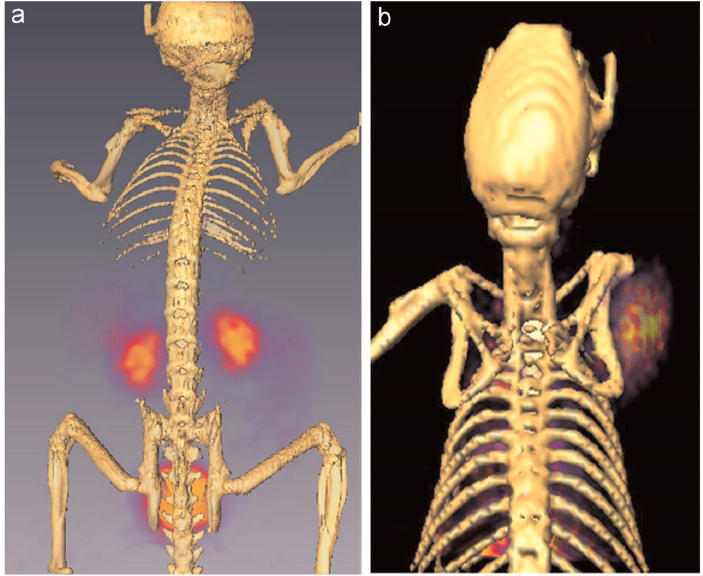
Figure 8. ( a ) Reconstructed PET/CT imaging in normal Balb/c mice with 68 Ga-DOTA–PAMAM-D; ( b ) Reconstructed PET/CT imaging in EAT bearing Balb/c mice with 68 Ga-DOTA–PAMAM-D. Reproduced with permission from (adapted from [110], Applied Radiation and Isotopes, 2015).